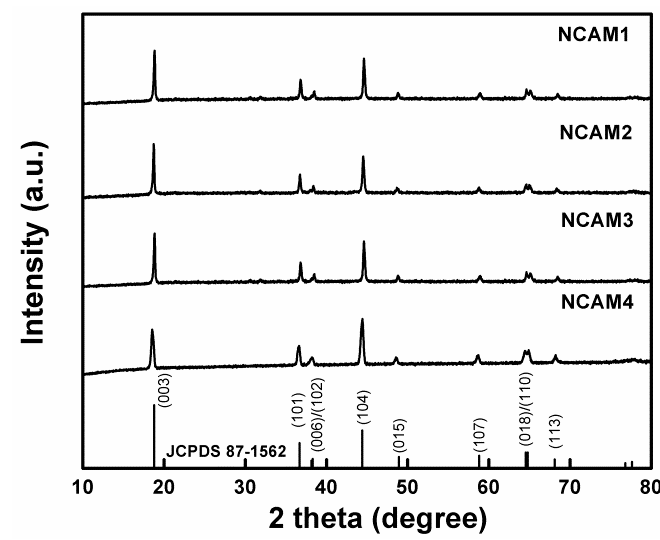
Figure 10. XRD patterns of as prepared NCA material with varying solution concentrations.